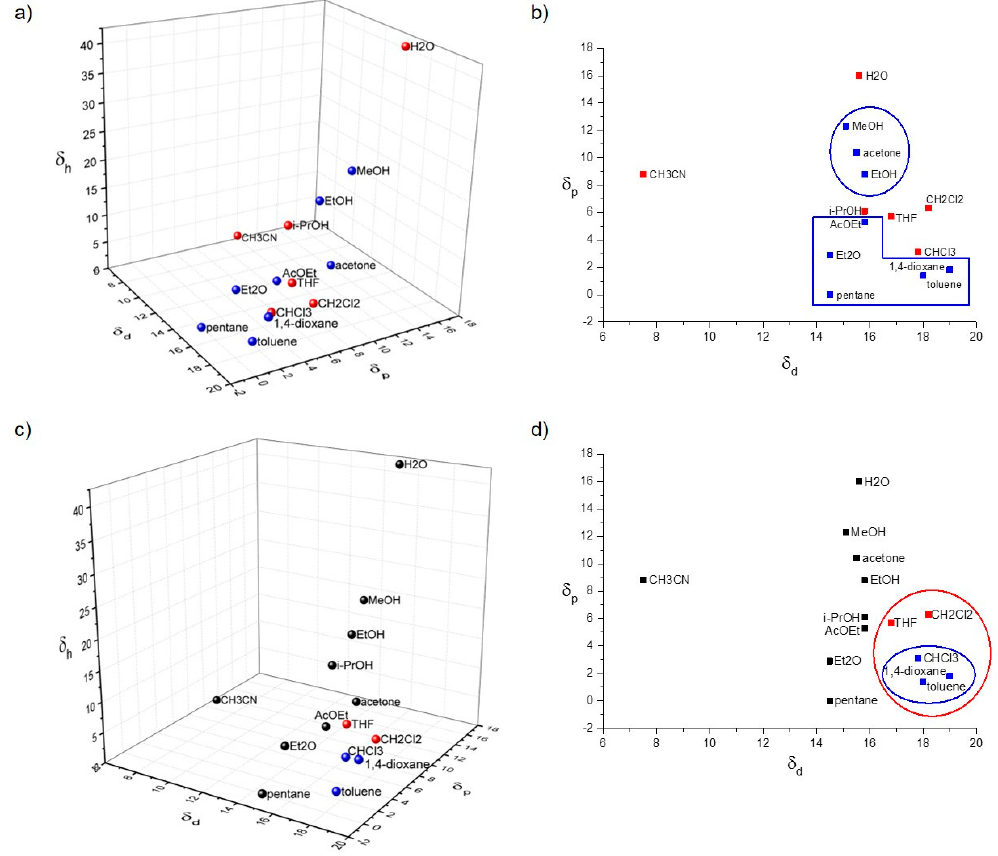
Figure 2. ( a , c ) HSPs representation and ( b , d ) 2D representation of δ p vs. δ d for the gelation study of compounds 4 ( a , b ) and 5 ( c , d ). Red: Solvents in which 4 or 5 are soluble; blue: solvents gelled.